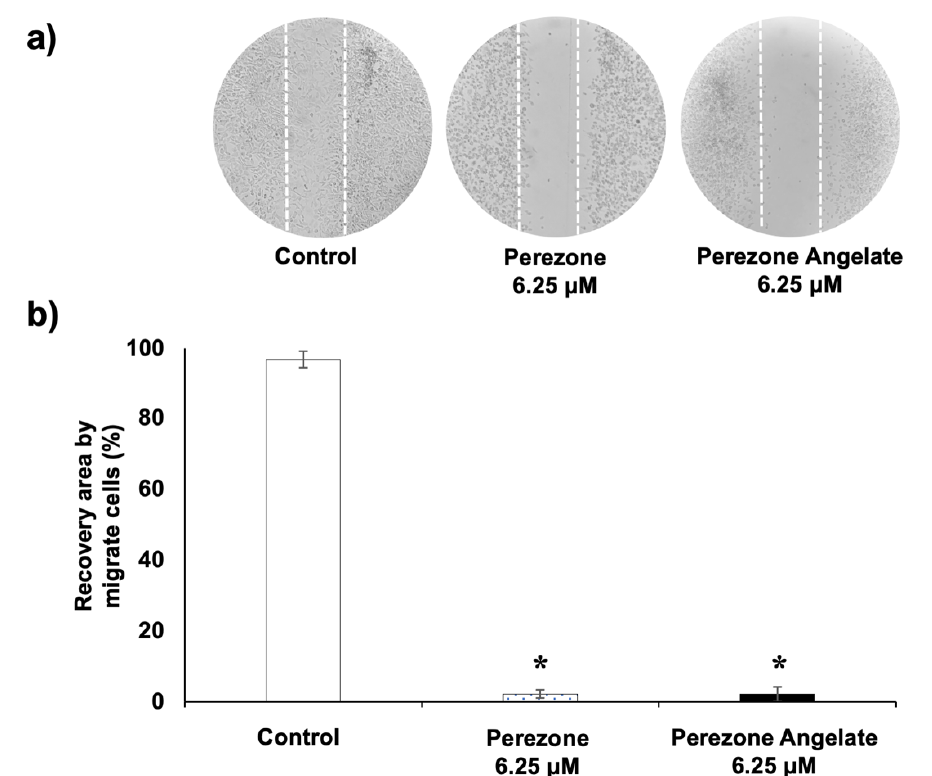
Figure 4. U373 cell migration in vitro is inhibited by perezone and perezone angelate. Wounds with a sterile tip were completed after cells reached confluence. Wound closure was quantified in the absence and presence of studied compounds after 48 h of treatment ( n = 3): ( a ) Representative image (40×) of U373 cells under treatment; ( b ) the bars express the average percentage of the covered area and the vertical lines express the ± SEM. Statistical analysis was performed by one-way ANOVA and Tukey’s post hoc test * p < 0.05 (between control and treatments).